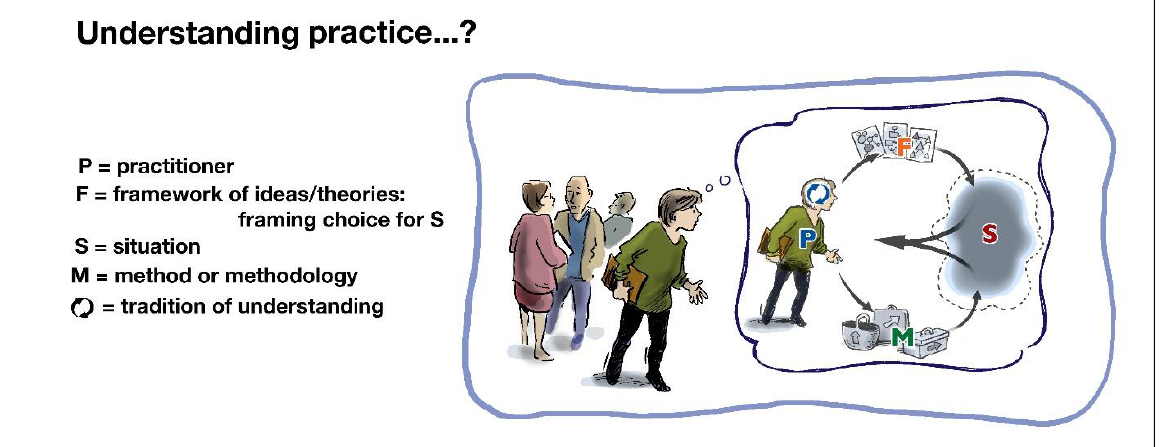
Fig A1-1: An heuristic for understanding the systemic dynamics of reflexive, research praxis: as a set of relational dynamics involving a practitioner (P) with a tradition of understanding and framework of ideas (F), and theories framing choice for a situation (S) and a method or methodology for inquiry. Understood as a system, complexity is added as research is done with others thus justifying co- inquiry (Ison and Straw